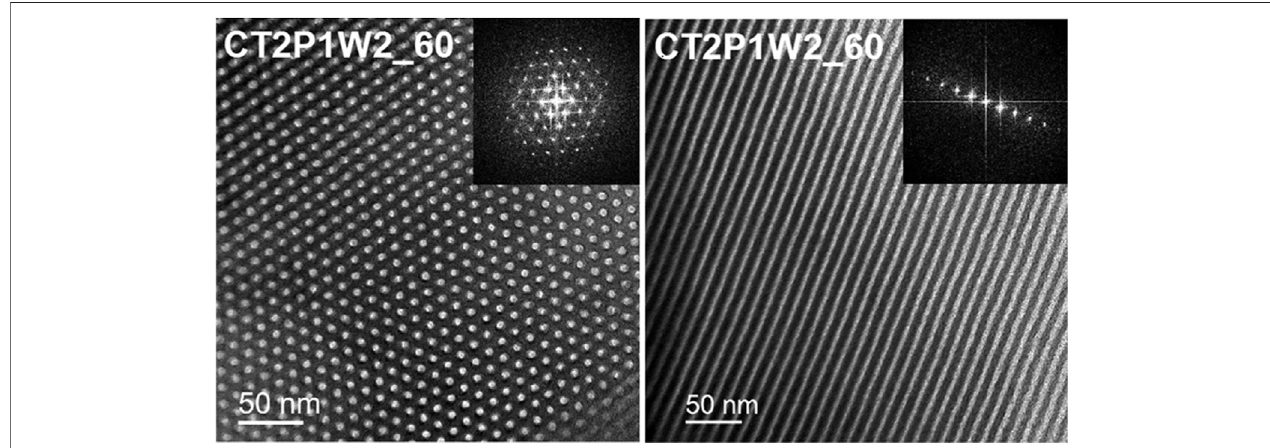
FIGURE4| Bright- fi eldTEMmicrographsoftransverseandlongitudinalviewsofwell-orderedmesoporouscarbonmaterialsobtainedbysoft-templatingoftannins [Reprinted with permission from (Castro-Gutierrez et al., 2018)].